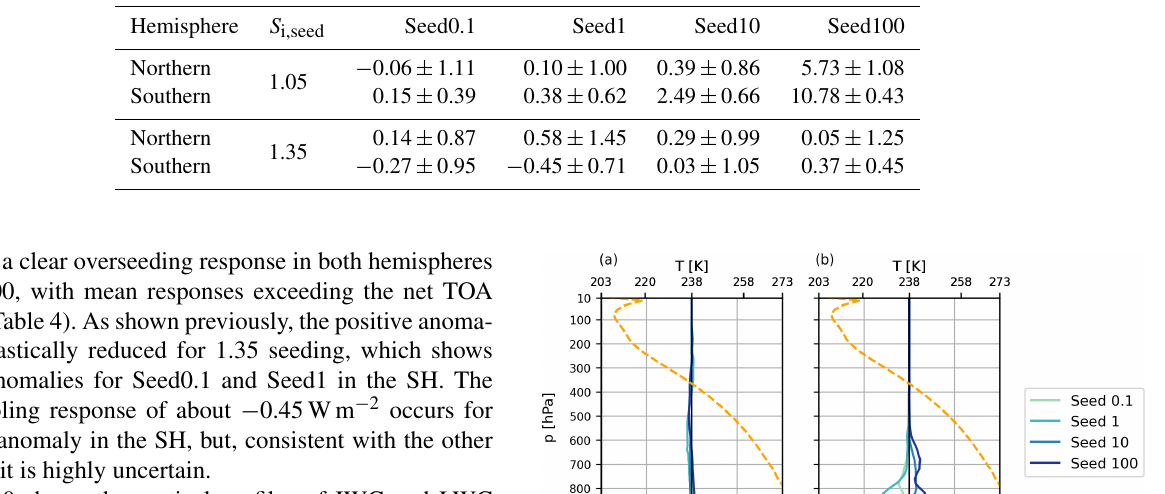
Table 6. Five-year annual mean net top-of-atmosphere total radiative balance in Wm − 2 in the Northern Hemisphere and Southern Hemi- sphere between 60 and 90 ◦ N/S for D19 for seeding with critical ice saturation ratios of 1.05 and 1.35. Each quantity includes the 95% confidence interval equating to 2 standard deviations of the mean values of the 5-year data.